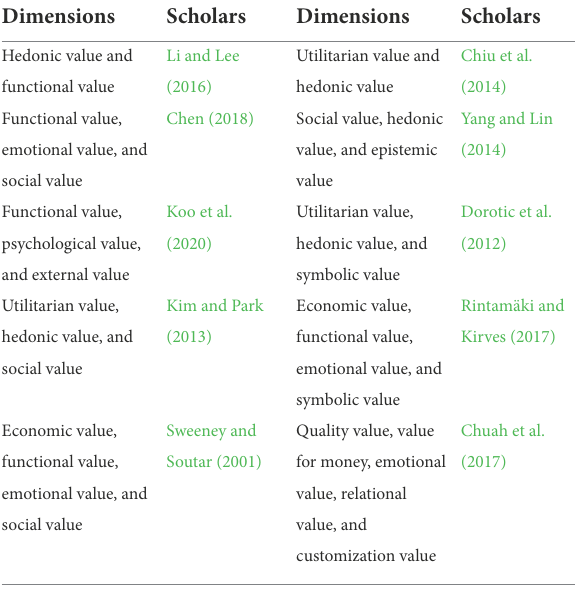
TABLE 1 A literature review of perceived value